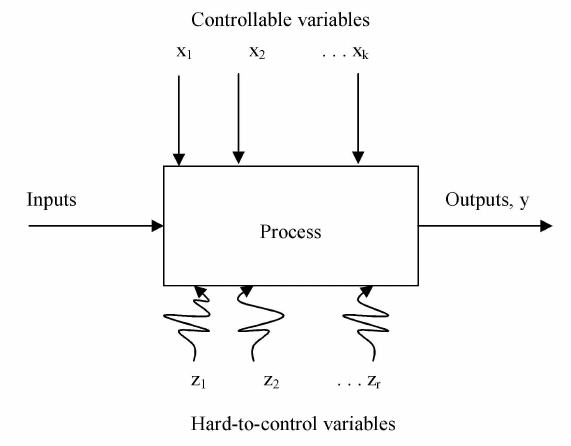
Figure 1: General model of a